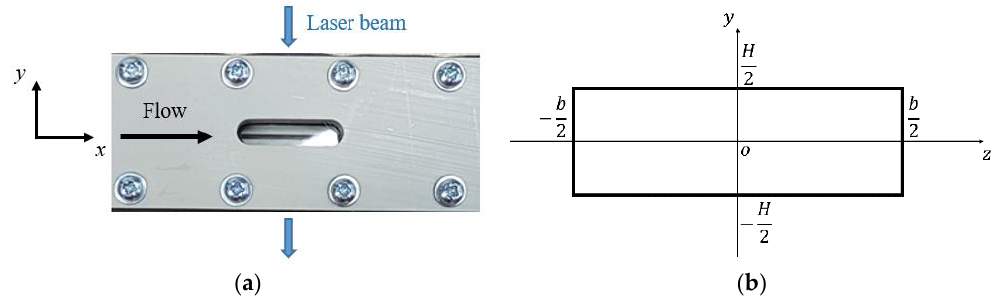
Figure 3. In ( a ), a global view of the test section along the channel from the point of the CCD camera. The blue arrows indicate the optical access for the laser beam and the black arrow shows the gas flow direction. In ( b ), a sketch of the channel cross-section along with the adopted Cartesian coordinate system.